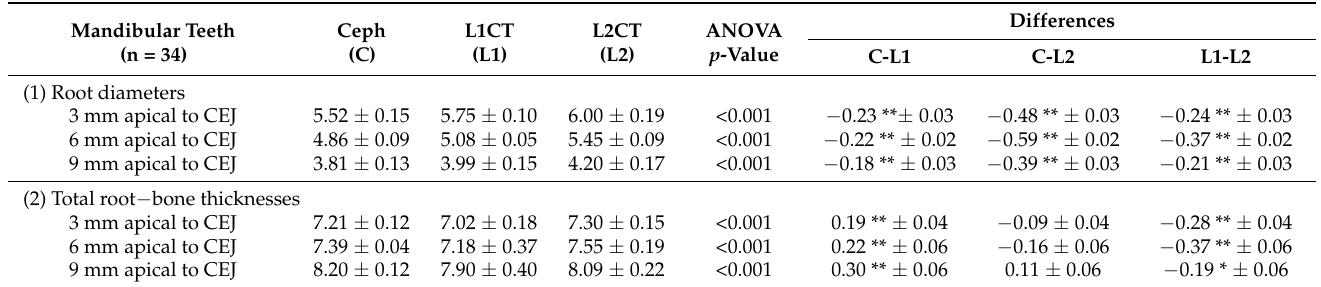
Table 3. Comparisons of root diameters and total root ‐ bone thicknesses between Ceph, L1CT, and L2CT.